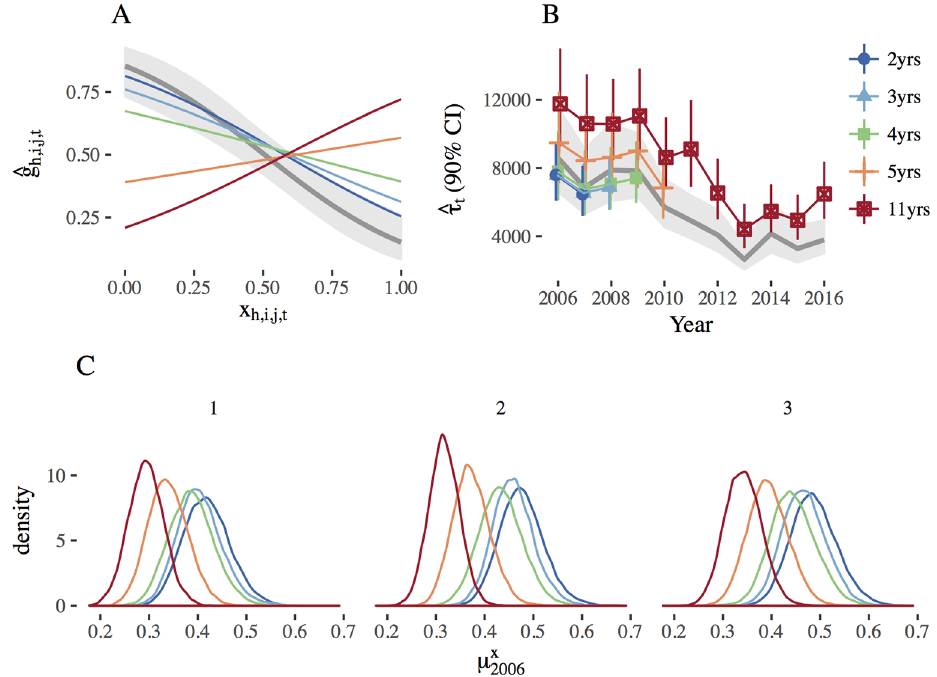
Fig 1. Sensitivity to the amount of detection-only data. A: Sightability model curves demonstrating the relationship between predicted detection probability ( ^ g ) and visual obstruction ( x h , i , j , t ) for each moose group j in plot i in h ; i ; j ; t stratum h in year t , B: abundance estimates ( ^ t ) by year with 90% credible intervals, and C: the posterior distribution of mean voc by strata h in 2006 ( m x ) for the fixed-effect, joint model-based approach following Fieberg et al . [8] with 2006 varying numbers of years of operational survey data included in the model. Gray bands and lines in (A) and (B) represent estimates and 90% confidence intervals for the sightability model curve and abundance estimates using the modified Horvitz-Thompson approach, respectively.